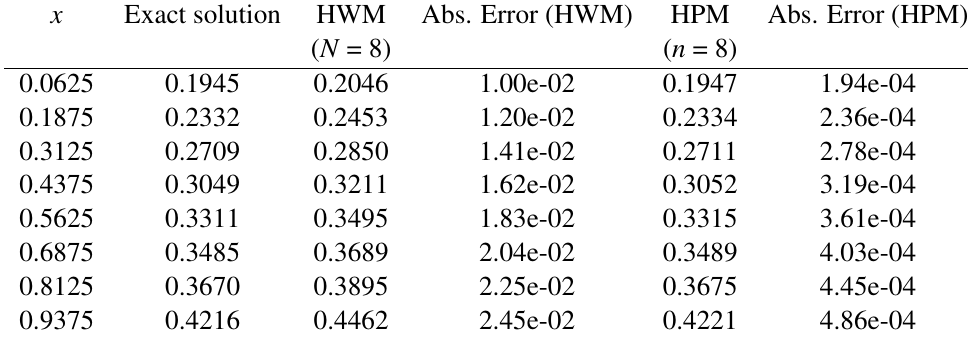
Table 1: Numerical result of Example